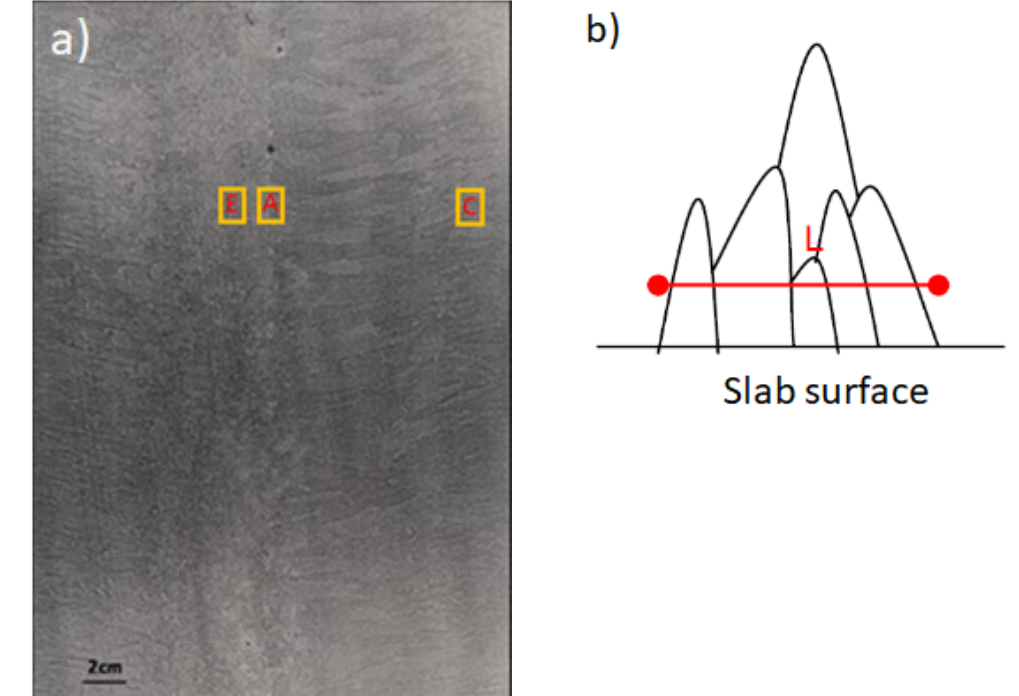
Figure 3. ( a ) Macroscopic etch of a continuous cast slab of steel 6A (containing 0.2 wt.% V and 0.032 wt.% P) showing the solidification structure and the positions of the columnar grain (C), equiaxed grain (E) and axial (A) regions chosen for EPMA, ( b ) illustration of the method used for austenite grain size measurement.